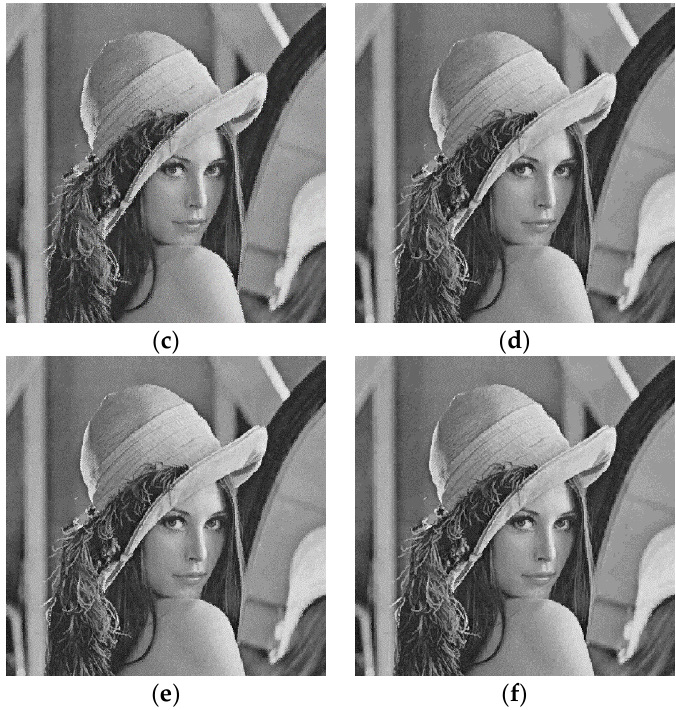
Figure 15. Visual investigation on Image Set 2 with quality factor 𝑄 = 8 : ( a ) input image; ( b ) JPEG decoded image; ( c ) ODBTC; ( d ) EDBTC; ( e ) DDBTC; and ( f ) DDBTC Gaussian method.